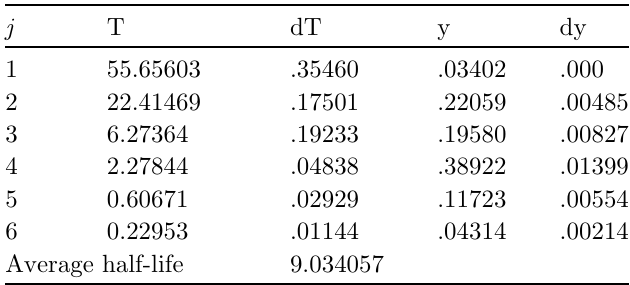
Table A2. Temporal DN parameters in more common form (with absolute dT and normalized a i